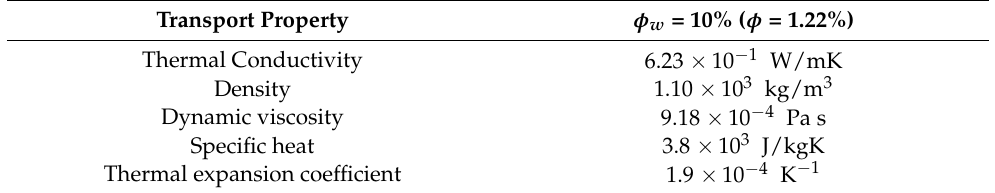
Table 2. The values of the transport properties of the NePCM at different nano-particle volume fractions.